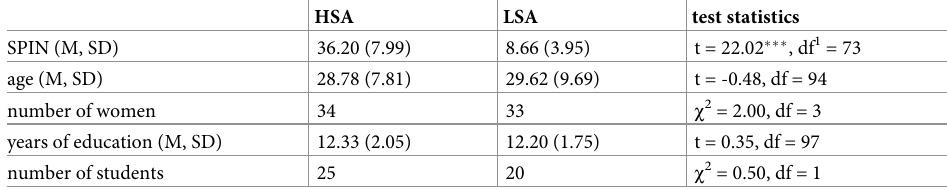
Table 1. Demographic sample